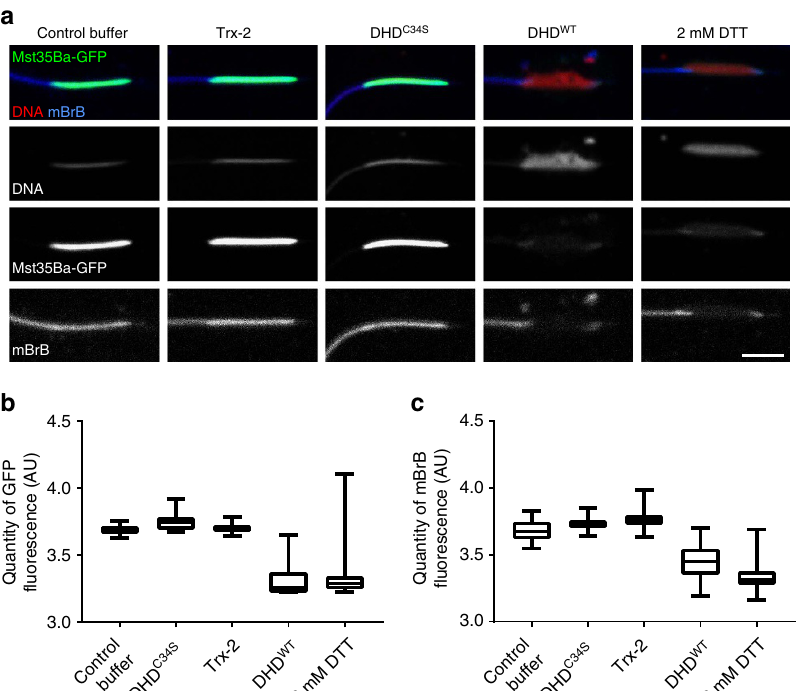
Figure 7 | DHD protein is sufficient to decondense sperm nuclei in vitro. ( a ) Confocal images of Mst35Ba-GFP sperm nuclei incubated with recombinant thioredoxins. The DHD WT recombinant thioredoxin induces nuclear decondensation and Mst35Ba-GFP removal in a way similar to DTT treatment. The sperm nuclei incubated with DHD C34S or Trx-2 recombinant proteins appear similar to sperm nuclei incubated with control buffer. Green: Mst35Ba-GFP, Blue: mBrB, Red: DNA. ( b , c ) Quantification of native GFP signal ( b ) or mBrB fluorescence ( c ) from sperm nuclei incubated with the recombinant thioredoxins. Error bars indicate SD calculated for 30 analysed nuclei for each experiment. Scale bar, 5 m